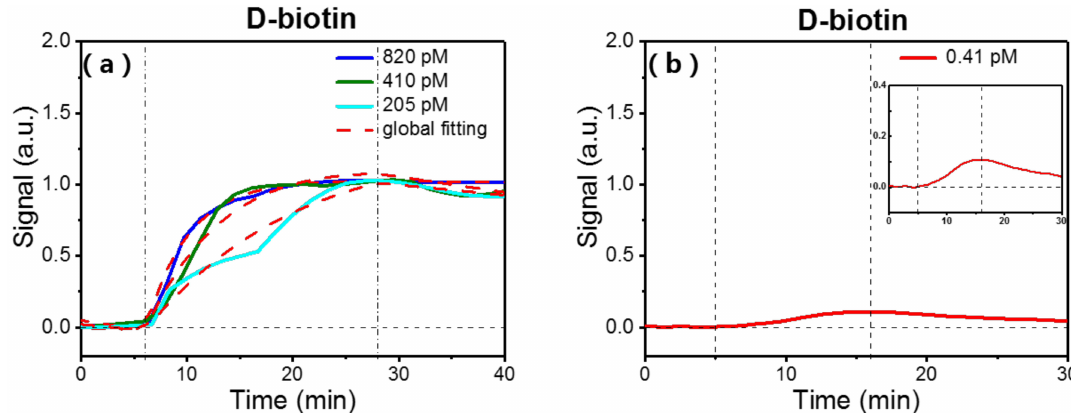
Figure 4. ( a ) Binding curves of surface-immobilized streptavidin with flowing biotin at respective concentrations of 205 pM, 410 pM, and 820 pM. Vertical lines indicate start of association and dissociation phases. Red dashed lines are global fitting results with the Langmuir reaction model; ( b ) Specific binding curve of surface-immobilized streptavidin with biotin at a concentration of 0.41 pM. Inset shows enlarged view of the binding